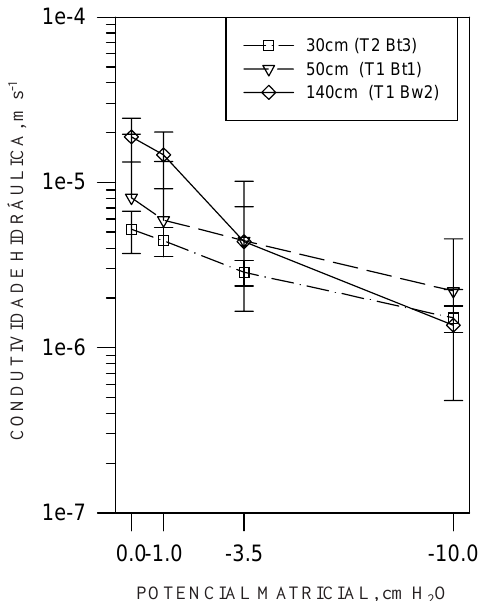
Figura 3. Condutividade hidráulica dos horizontes Bt1 e Bw2 do perfil 1(T1) e Bt3 do perfil 2 (T2).